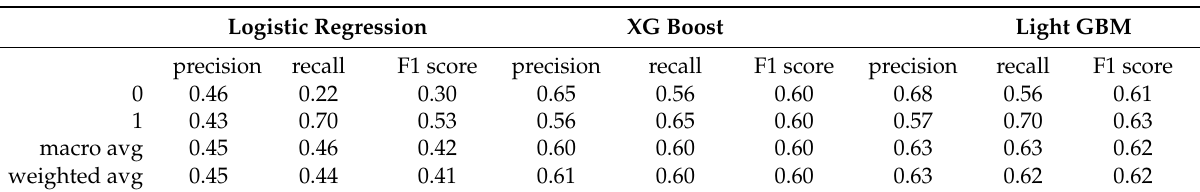
Table 9. Classification report for weekly models.